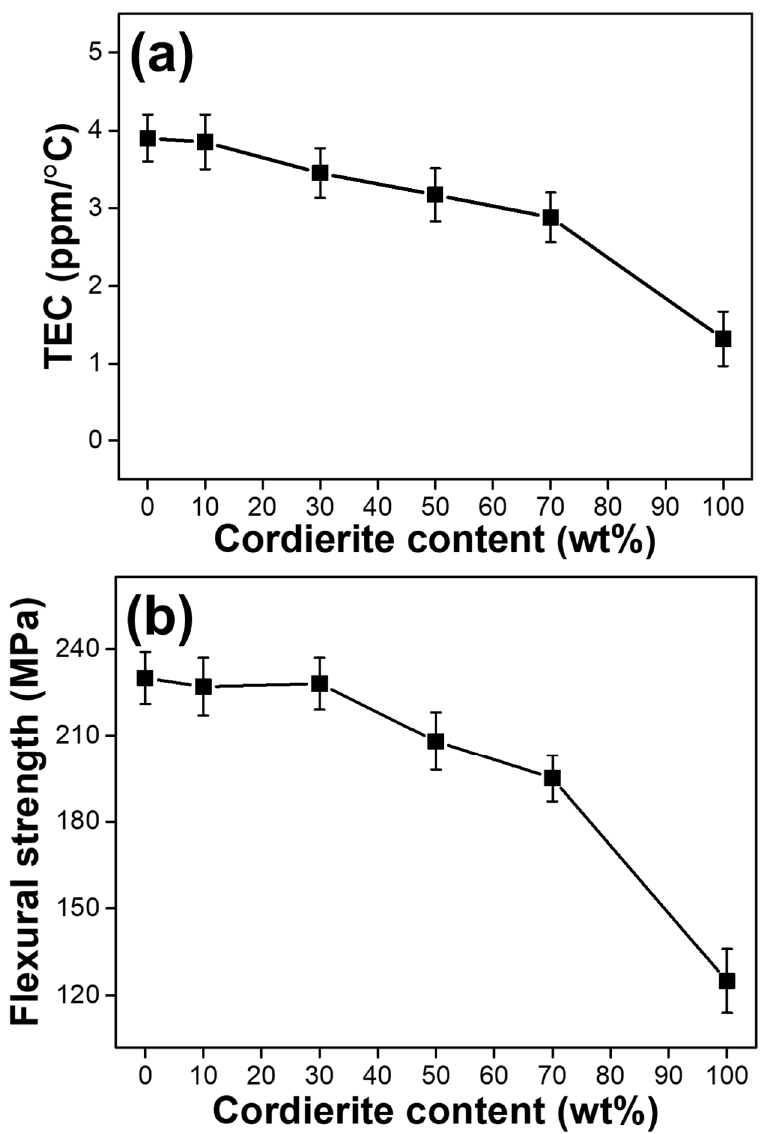
Figure 5. Variation in the physical and mechanical properties of mullite–cordierite composites with the cordierite content: ( a ) TEC and ( b ) flexural strength.